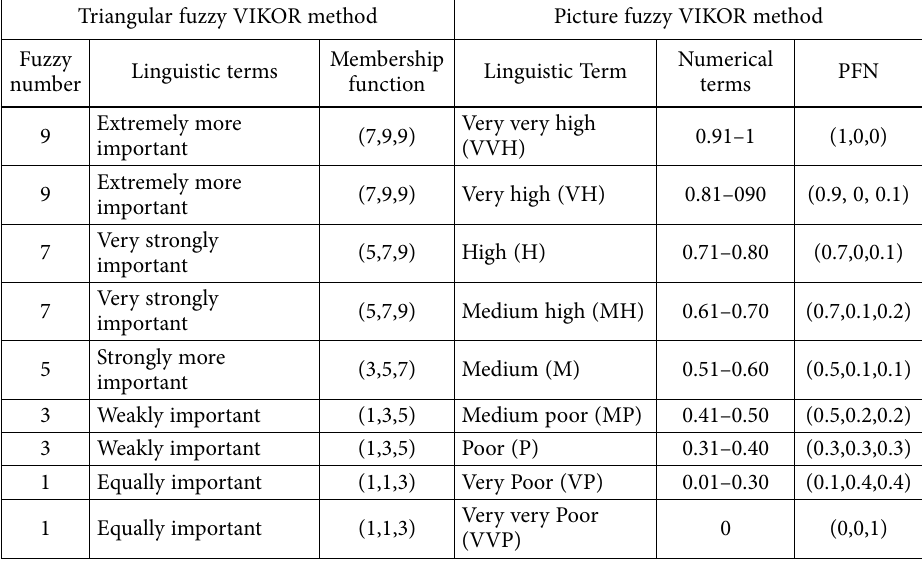
Triangular fuzzy VIKOR method Picture fuzzy VIKOR